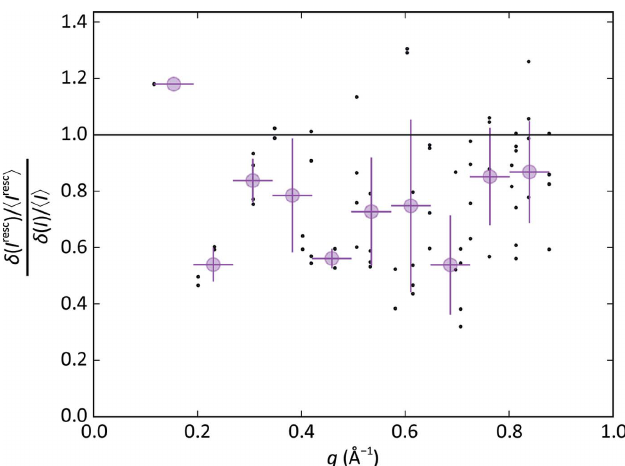
Figure 8 Lattice-scaling effect. Ratio between the peak intensity distribution widths (cid:6) ( I resc )/ h I resc i and (cid:6) ( I )/ h I i after and before scaling, respectively. The ratios are shown as a function of the in-plane momentum transfer of the reflection. Circles in magenta represent the average over resolution